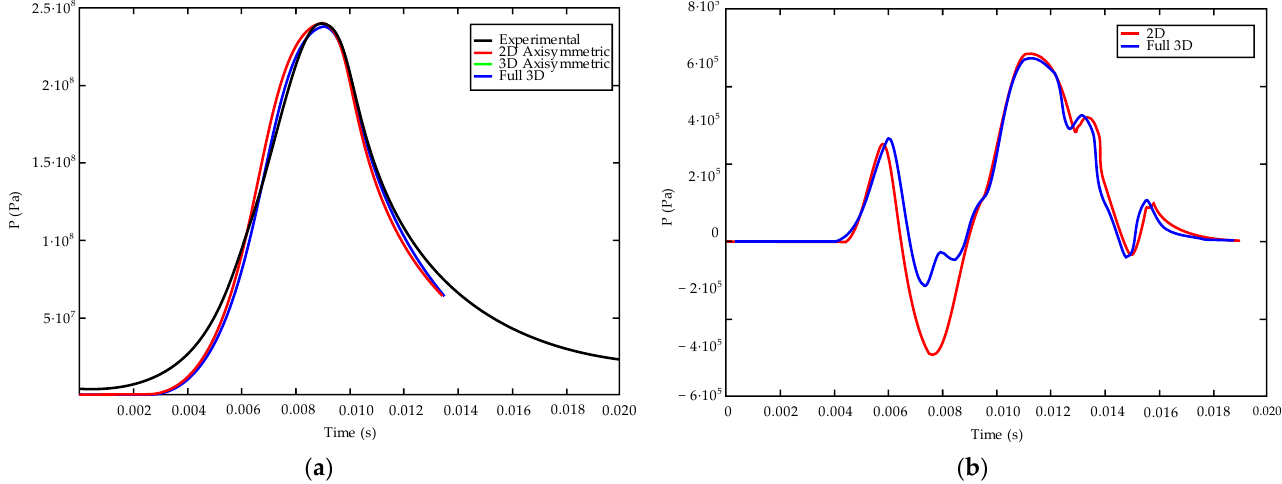
Figure 2. Experimental and numerical pressure evolution with time: ( a ) pressure evolution at the breech; ( b ) differential pressure between breech and port.